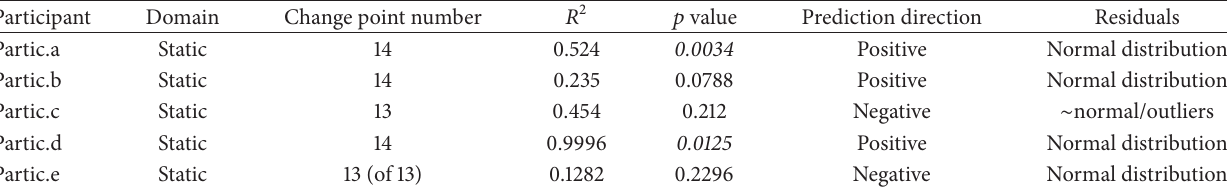
Table 3: SPRE analysis of 5 participants for the static posture